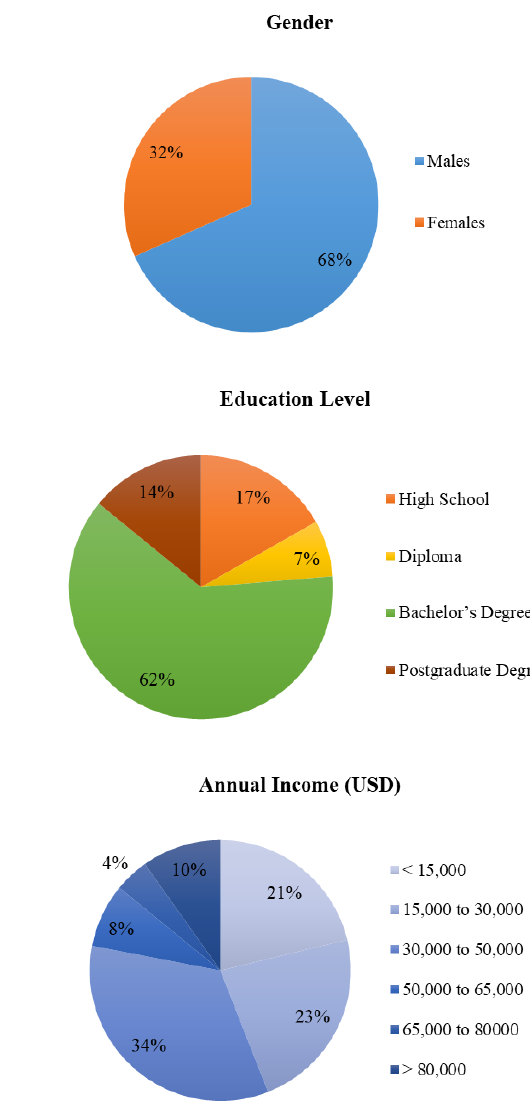
Figure 5. Demographic details of the respondents.